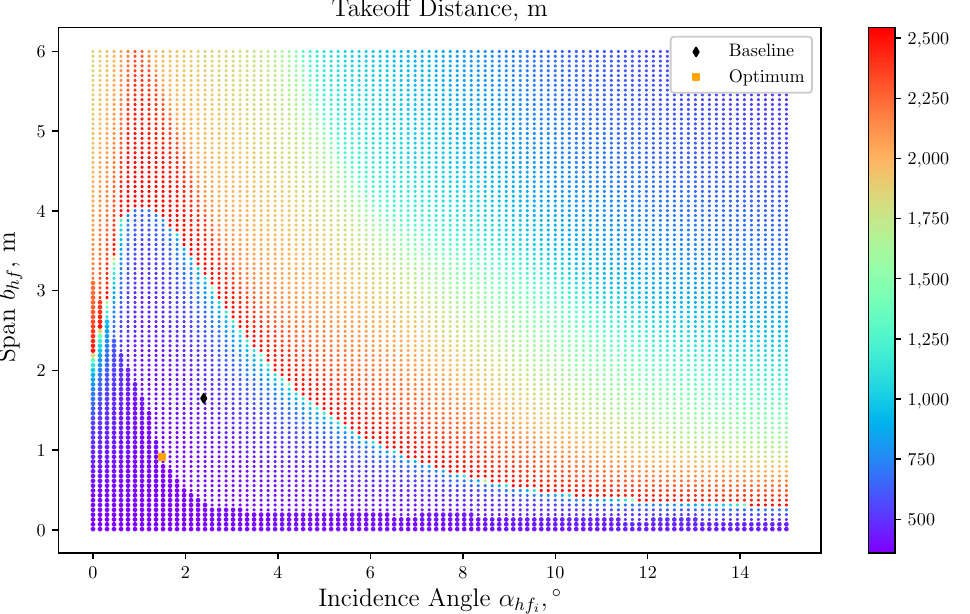
Figure 13. The design space for water-takeoff distance minimization to find the span and incidence angle of the hydrofoil. The darker region with larger radii depicts the area satisfying the lift